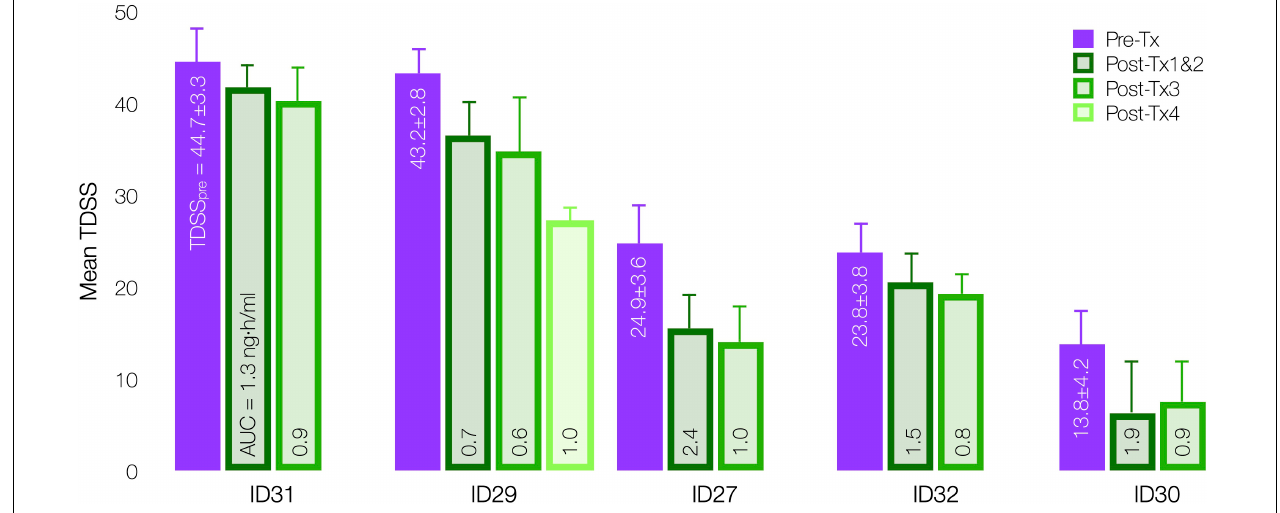
FIGURE 9 | Effect of CT38 individual treatment AUC on mean TDSS pre-treatment (purple bar) and post successive treatments (green bars), with standard deviations (error bars) and the level of AUC delivered in each successive treatment, by